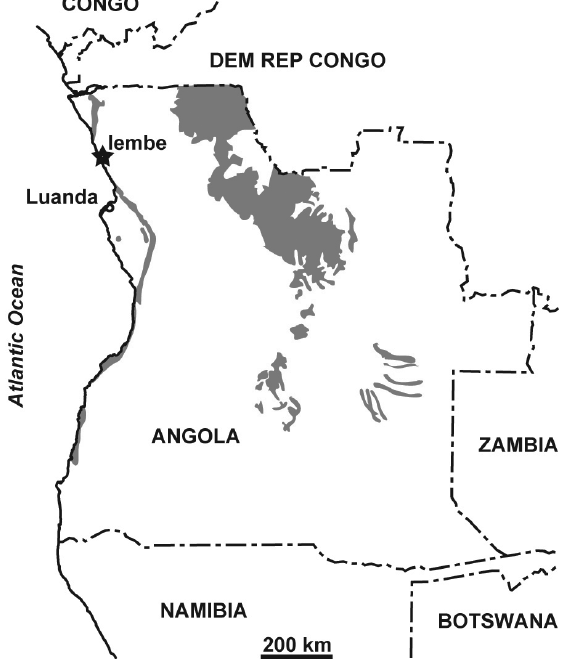
Fig. 1 – Map of Angola, showing the Tadi site (star; 08 ◦ S/13 ◦ E) and the distribution of Cretaceous strata (grey) in Angola.